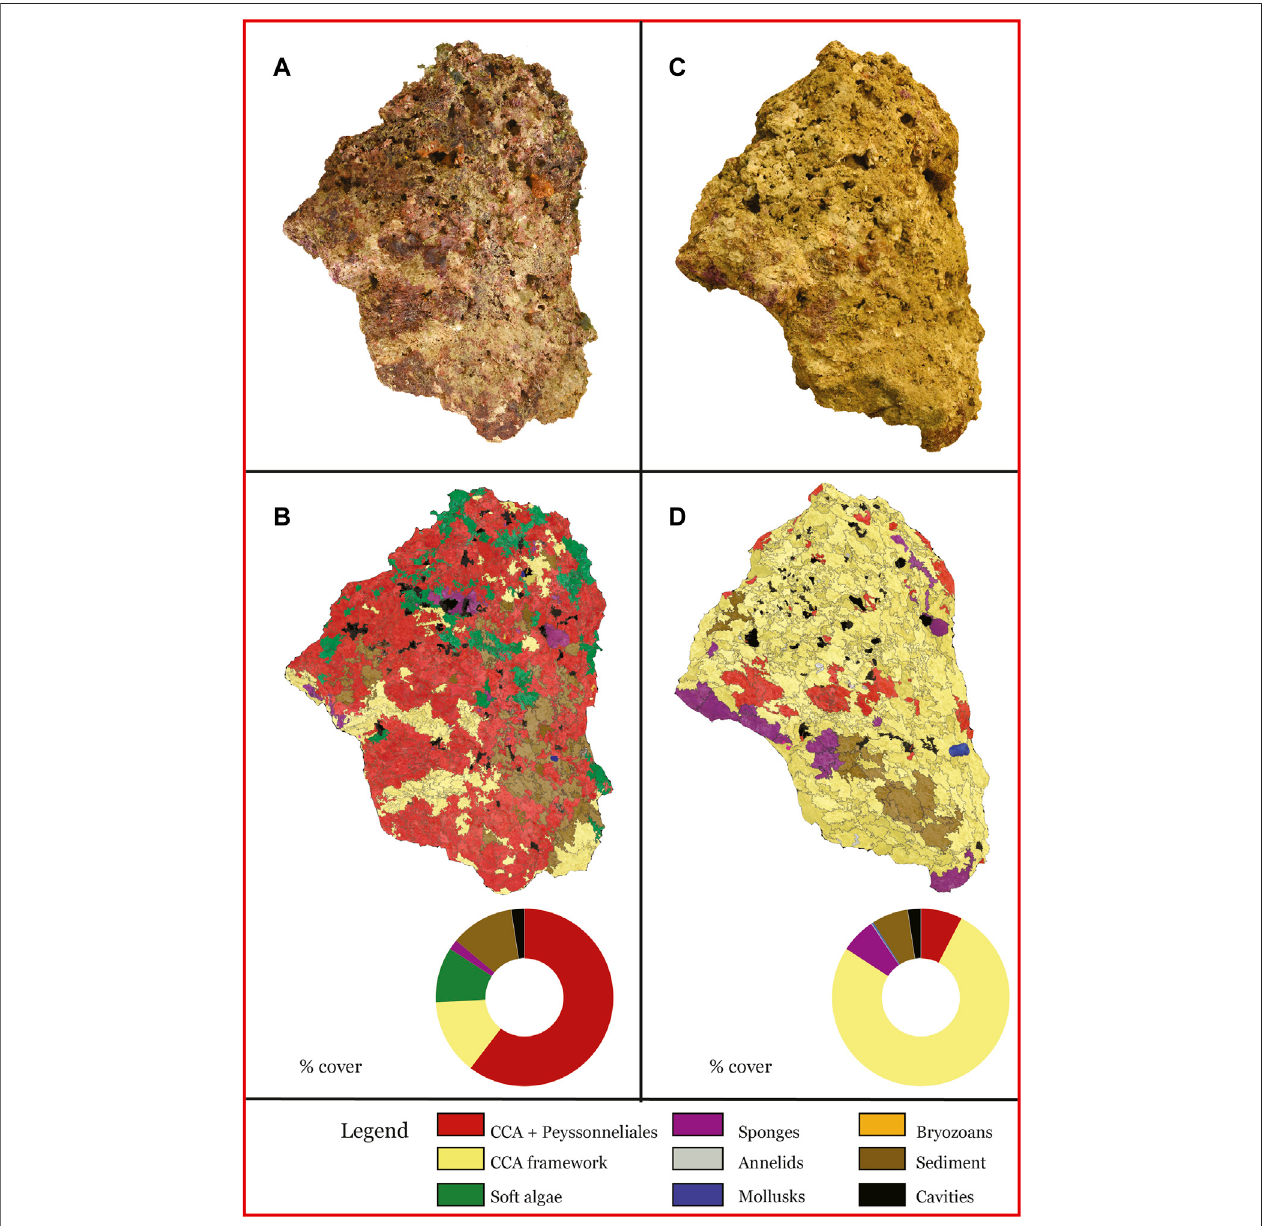
FIGURE 3 | East side of the sample CBR2_3_7c, pictured (A,C) and fragmented (B,D) . (A) Original east side; (B) results of the fragmentation of the east side with the ring chart of covers; (C) east side after the canopy removal; (D) results of the fragmentation of the east side after the canopy removal with the ring chart of covers. Among the 12 categories indicated in the Methods, only the ones actually detected have been reported in the legend.